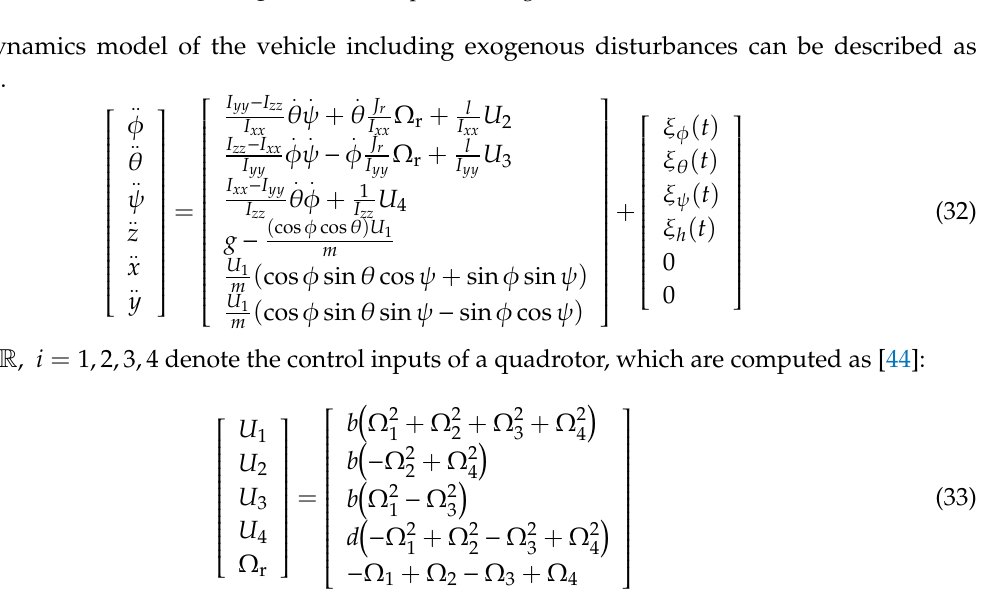
Table 1. System parameters of a quadcopter.